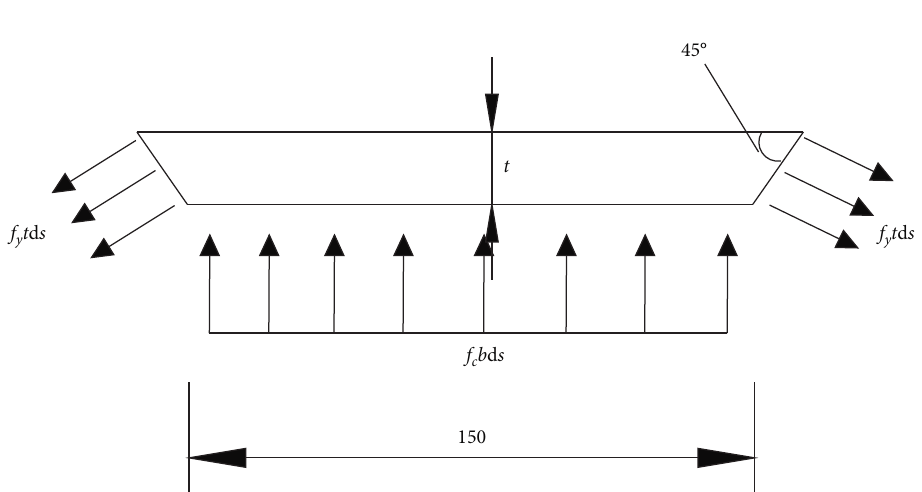
Figure 22: Stress condition of upper isolation body at steel